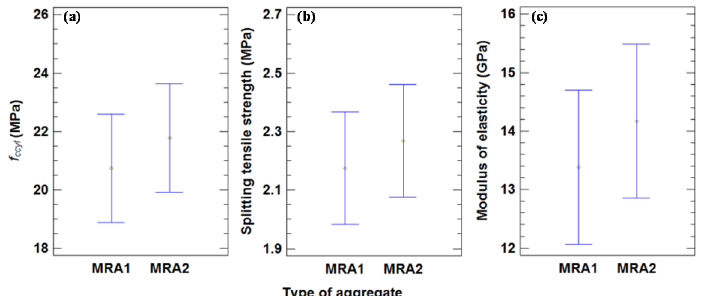
Figure 12. ( a ) Mean values of compressive strength in cylindrical specimens and 95% LSD intervals vs. type of MRA. ( b ) Mean values of splitting tensile strength in cylindrical specimens and 95% LSD intervals vs. type of MRA. ( c ) Mean values of modulus of elasticity and 95% LSD intervals vs. type of MRA.